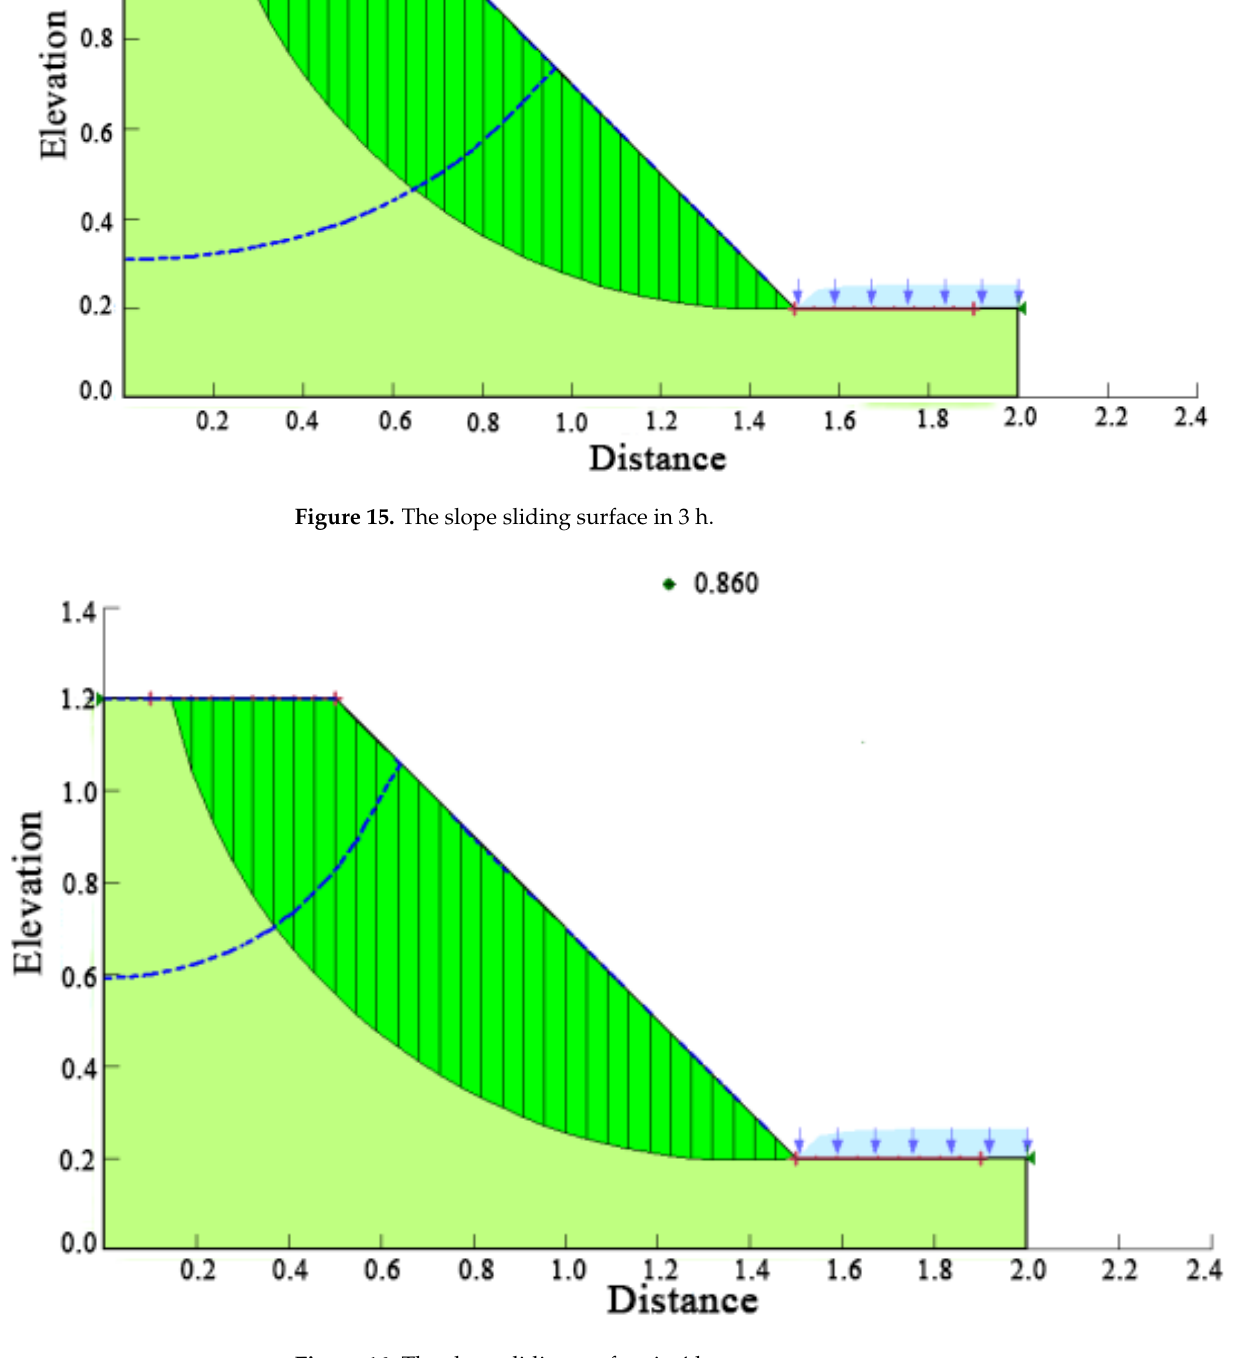
Figure 16. The slope sliding surface in 4 h.